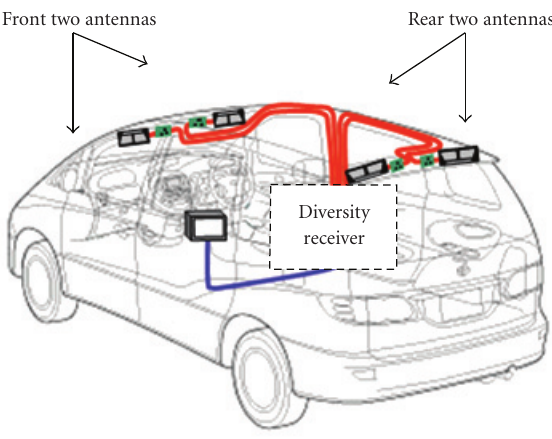
Figure 3: Antennas on